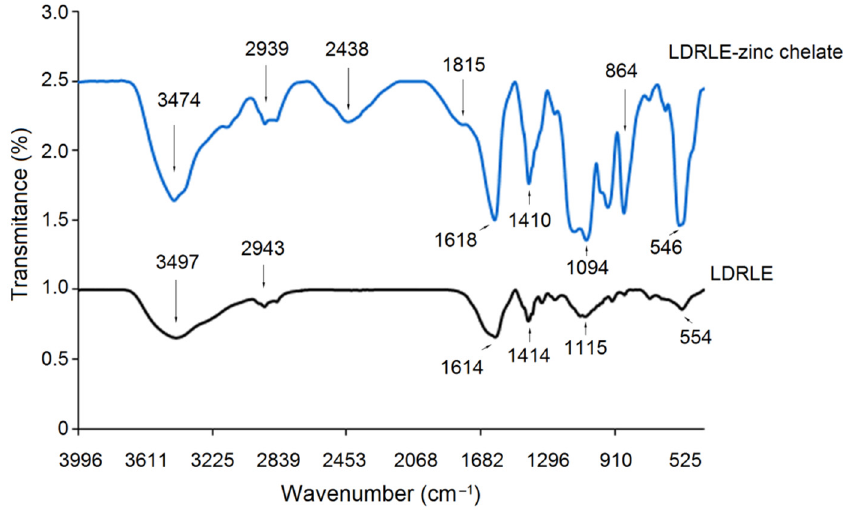
Figure 5. Fourier ‐ transformed infrared spectra of LDRLE ‐ zinc chelate and LDRLE.